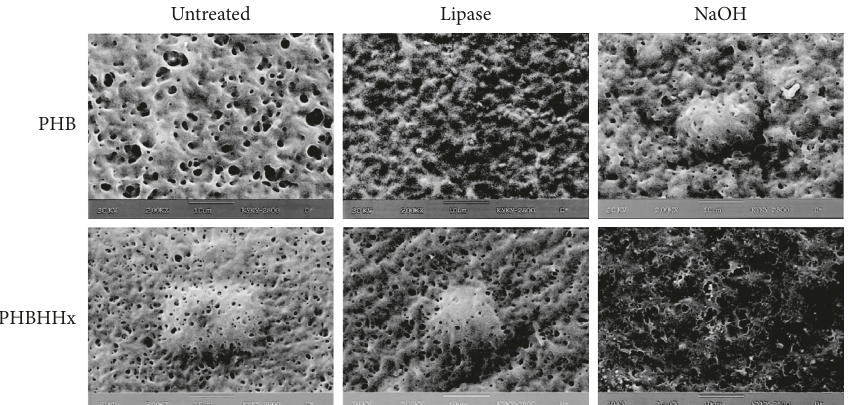
Figure 1: SEM micrographs of PHB and poly(3-hydroxybutyrate- co -3-hydroxyhexanoate) (PHBHHx) films before degradation (untreated) and after lipase and 1N NaOH catalysed hydrolysis (adapted with permission from ref. [20]).